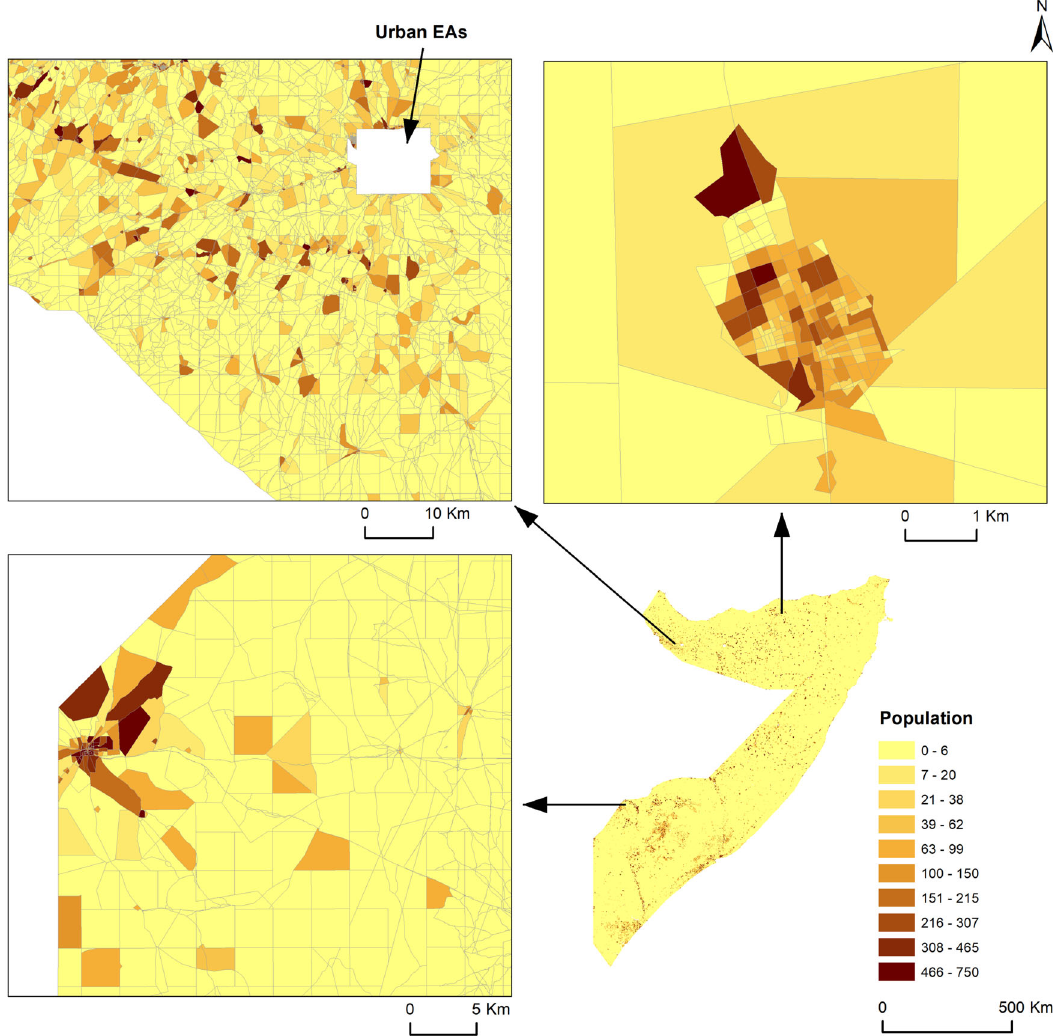
Fig. 3 Primary units (PU) and population sizes in rural areas generated from the splitting process. After the splitting process, the rural territory in Somalia was subdivided into small geographic units and each unit has total population estimates computed from high gridded population dataset.